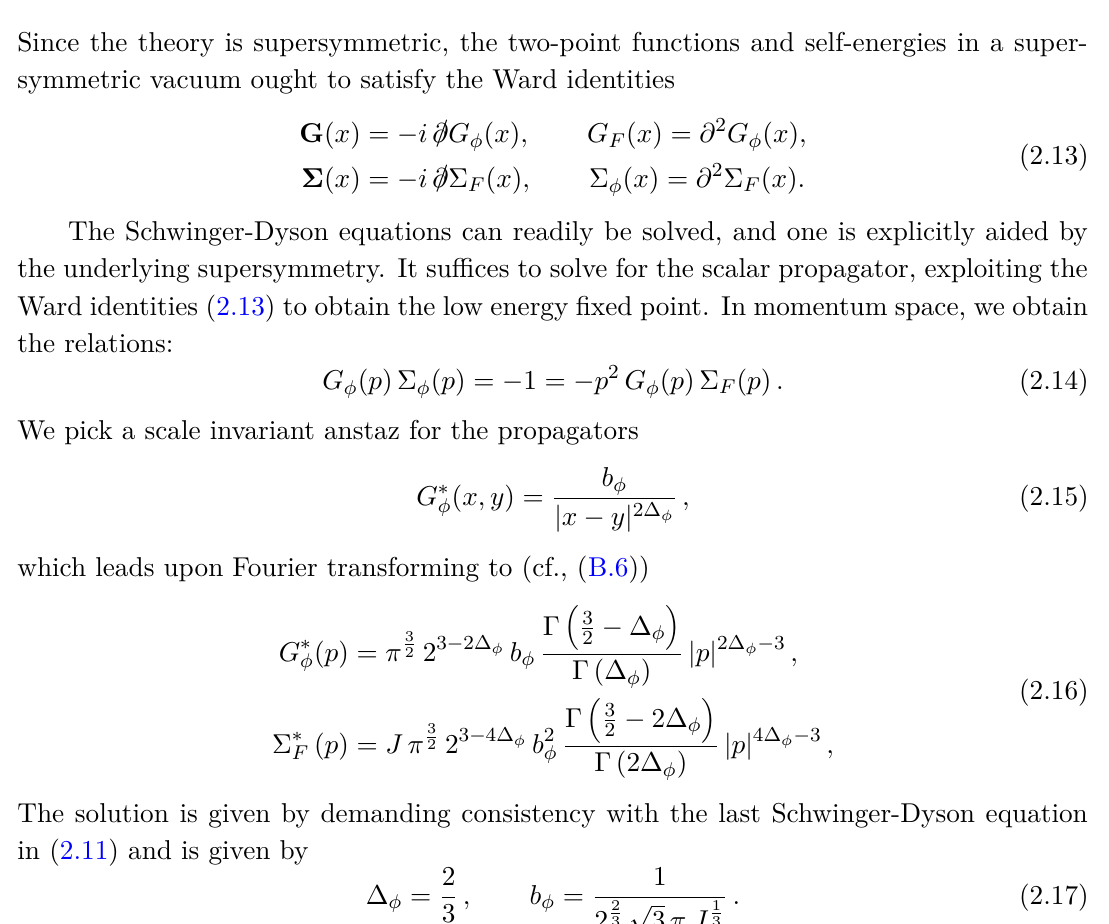
Figure 1 . The diagrammatic representation of the Schwinger-Dyson equation for cubic superpo- tential